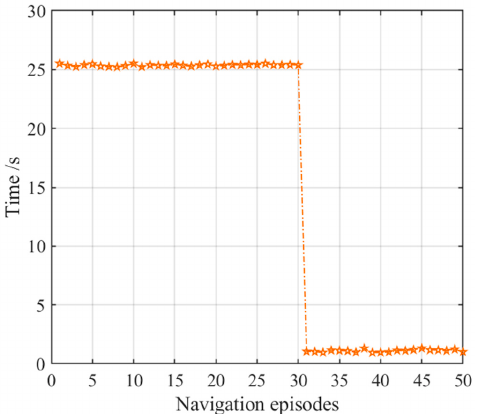
Figure 15. Number of steps with the NLM-HS. Blue asterisks indicate the navigation steps for each navigation episode.